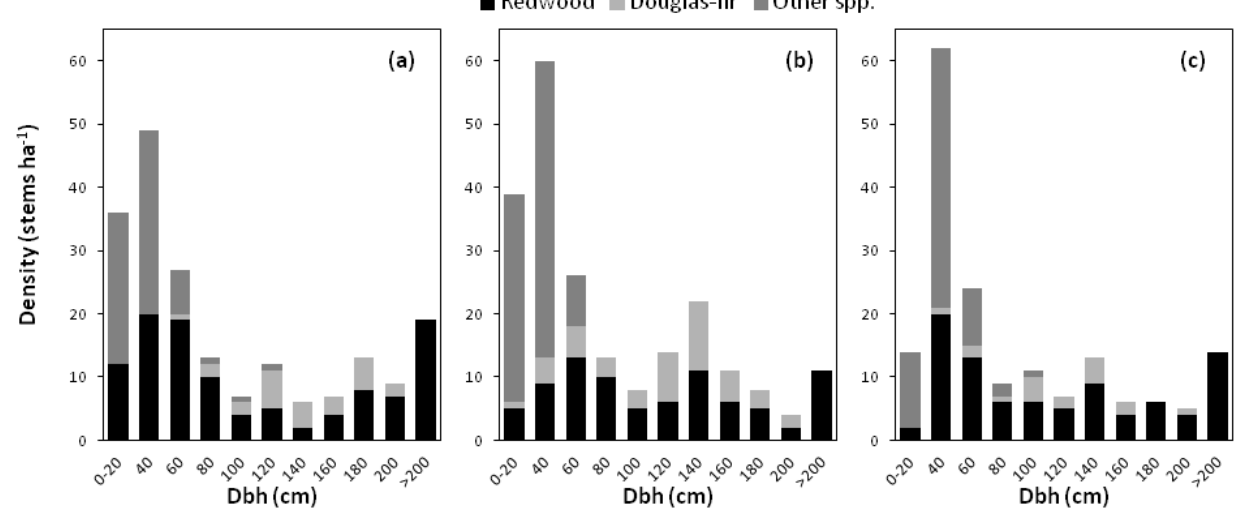
Figure 2. Diameter distributions for all trees ≥15 cm dbh in ( a ) Governor’s ( b ) Upper Salmon and ( c ) Elkhead Springs old-growth reference plots at Headwaters Forest Reserve, California.